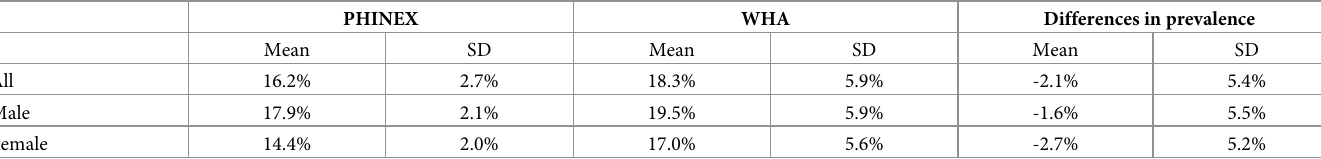
Table 3. Prevalence estimates in PHINEX and WHA.